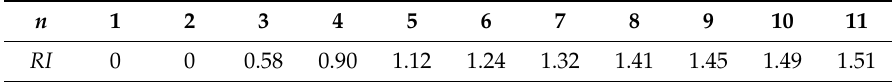
Table 5. Numerical value of consistency index of